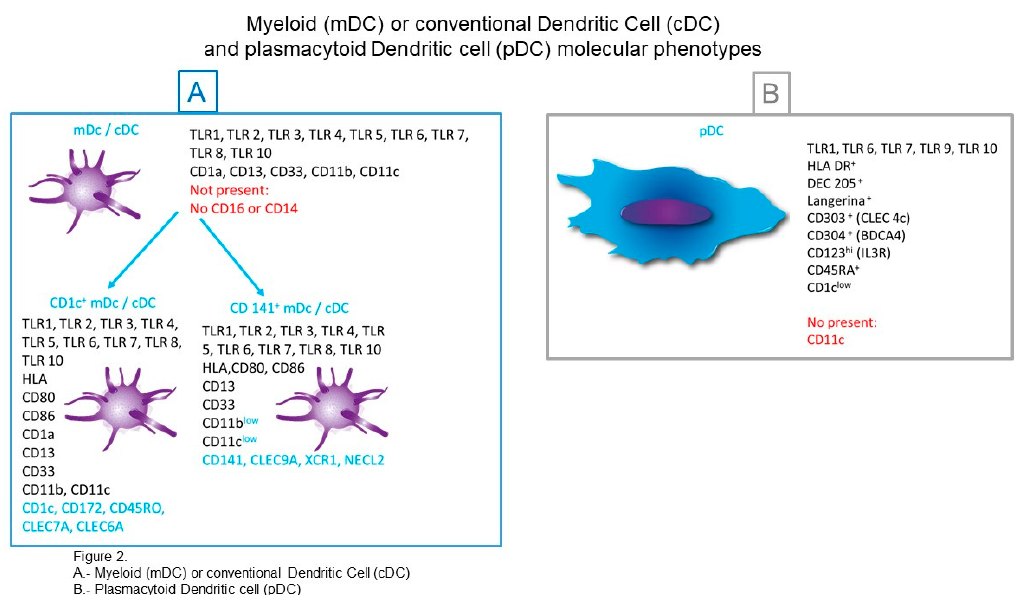
Figure 2. Myeloid or conventional dendritic cells and plasmacytoid dendritic cells molecular phenotypes. Schematic summary of ( A ) myeloid or conventional dendritic cells and ( B ) plasmacytoid dendritic cells molecular phenotypes.